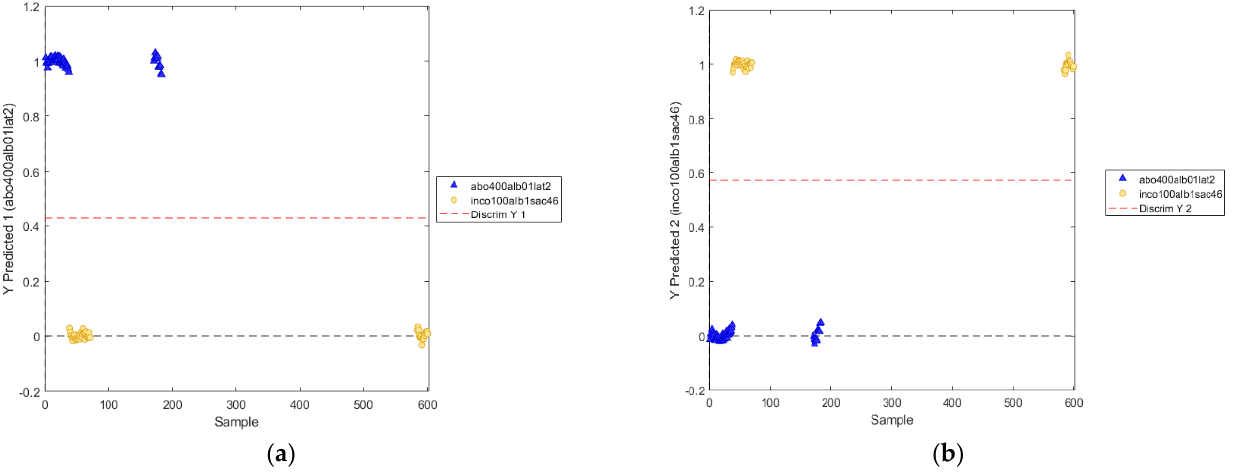
Figure 14. Positions of the discrimination boundary as determined by PLS − DA model (utilized wavelength ranges: 811–991 nm, 1018–1111 nm, 1352–1414 nm, 1527–1722 nm) for the two